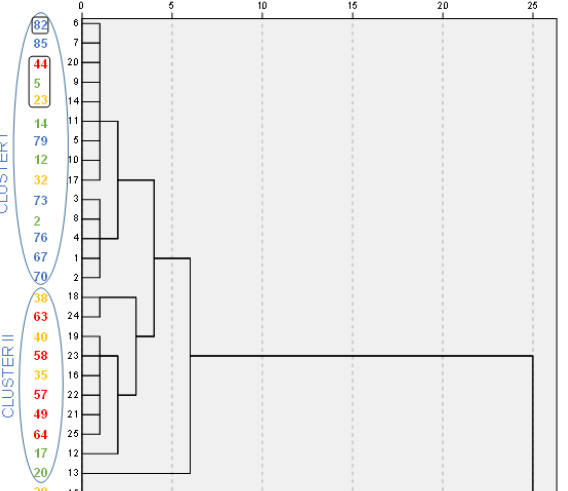
Figure 10. Hierarchical dendrogram based on PCA of DGT curves. Two clusters could be observed (indicated by ellipses). One of these groups (Cluster I) together, mostly samples taken at lower temperatures, and the other cluster (Cluster II) at higher temperatures or longer reaction times. The numeration of the experiments corresponds with Table S1. In blue, the samples from the 80 °C series, in green from the 170 °C series, in yellow from the 190 °C series and in red from 205 °C series. The samples in boxes are samples synthesized using equivalent reaction times based on the specifications of the microwave manufacturer.